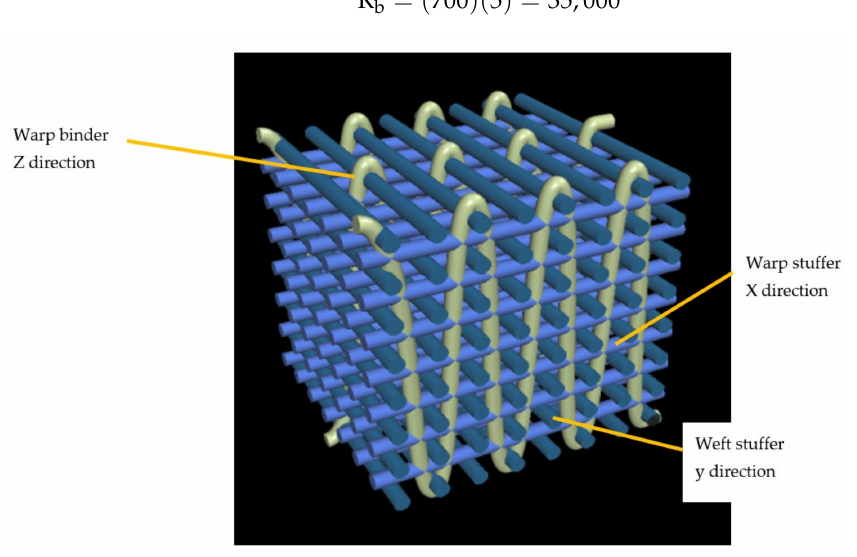
Figure 5. Unit cell, orthogonal 3D woven architecture:7 warp layers, 8 weft layers, 28 fibre ends per unit cell, and 5 warp binder ends.